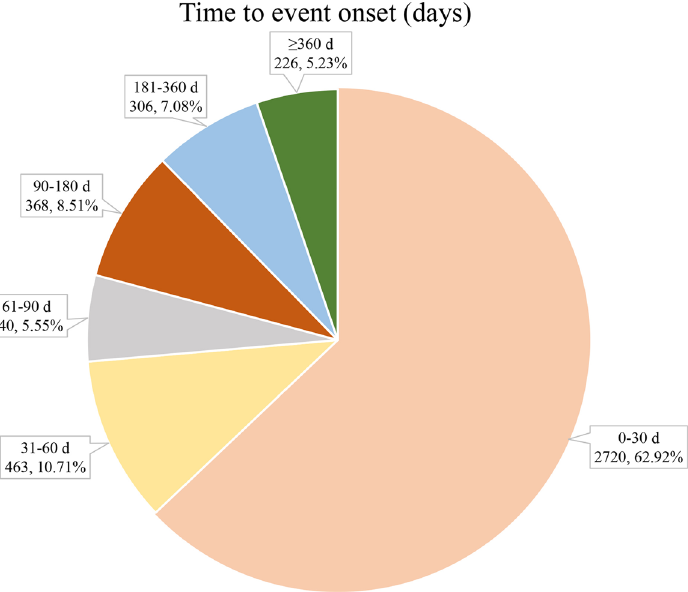
Figure 1. Time to onset of niraparib-related